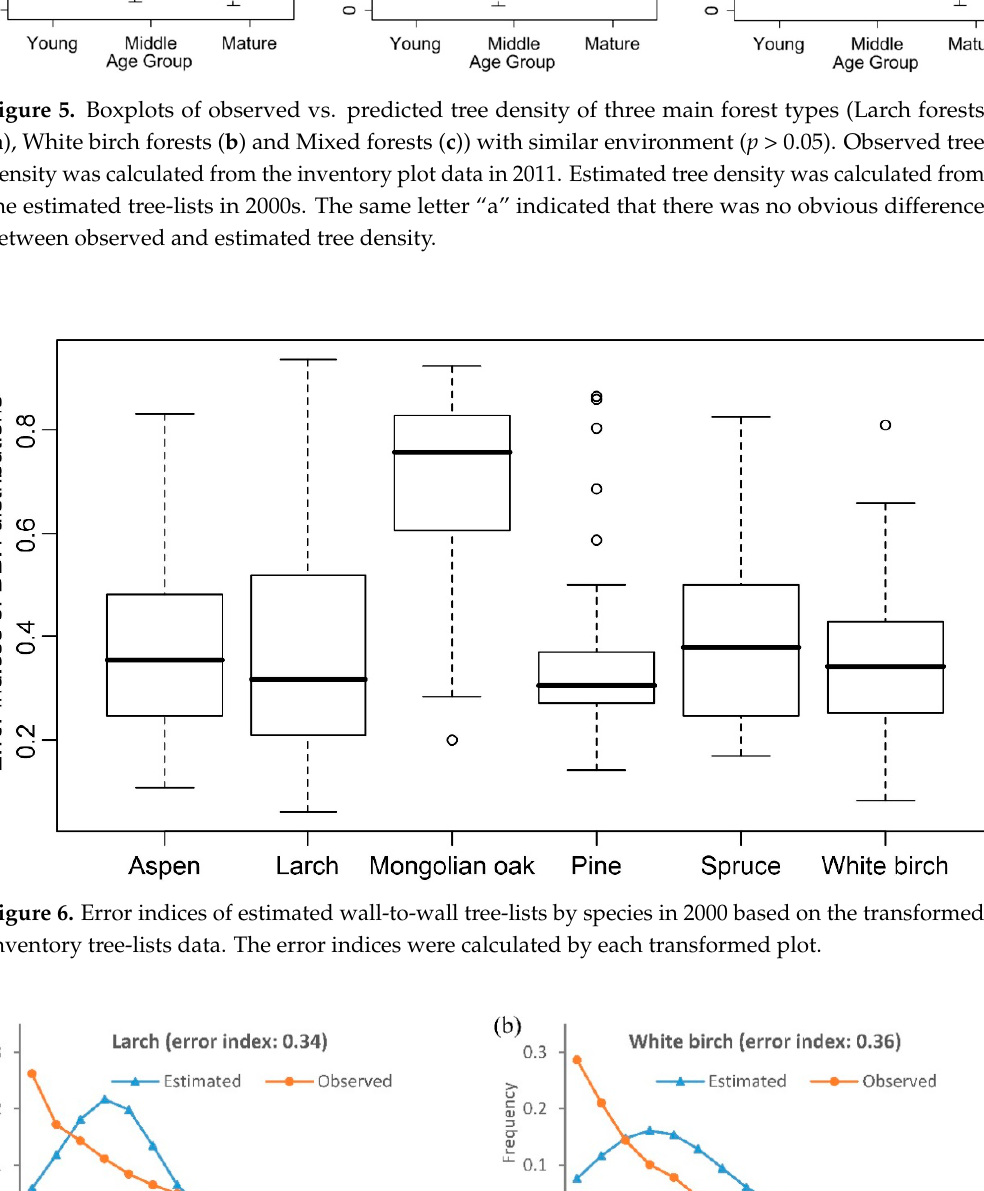
Figure 7. DBH distributions by species (larch ( a ), white birch ( b ), pine ( c ), aspen ( d ), spruce ( e ), Mongolian oak ( f )) of the observed vs. estimated wall-to-wall tree-lists based on the transformed inventory tree-lists data. The error indices were calculated by regarding all transformed plots as a whole. Figure 8. Estimated tree-lists of the study area in 2000 by species (larch and white birch ( a ); aspen, pine and willow ( b ); black birch and Mongolian oak ( c ); spruce ( d )).